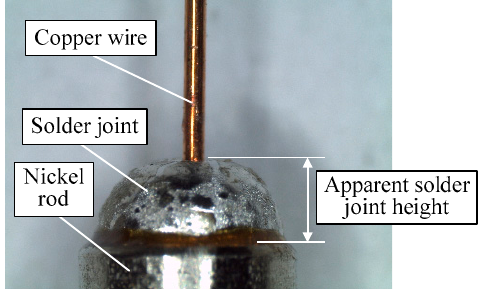
Figure 2. Solder joint before pullout test and its apparent height.